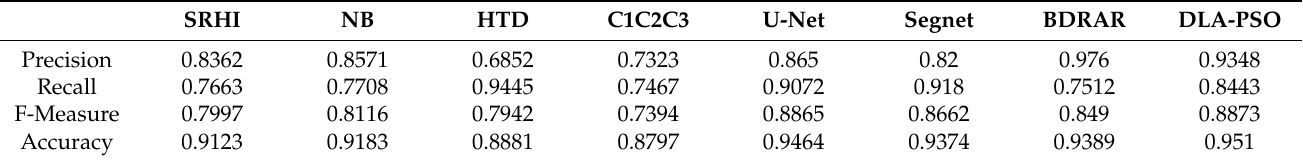
Table 3. Vienna shadow-test-evaluation index.